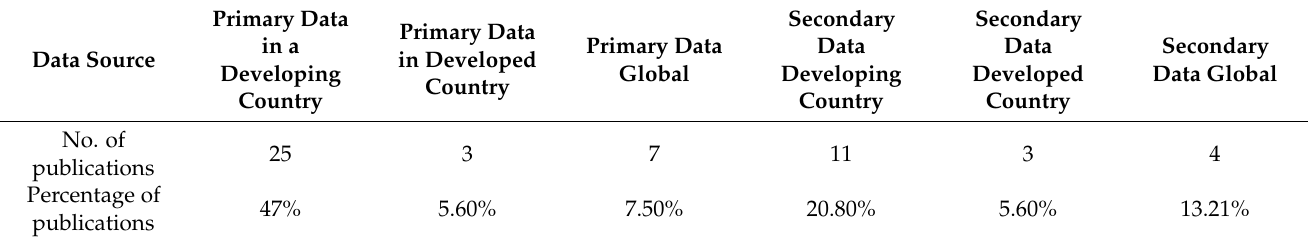
Figure 4. Map of locations of studies about smallholder farming (2020–2021). NB: Mouse-over enabled. Table 1. Table displaying types of data at country and global